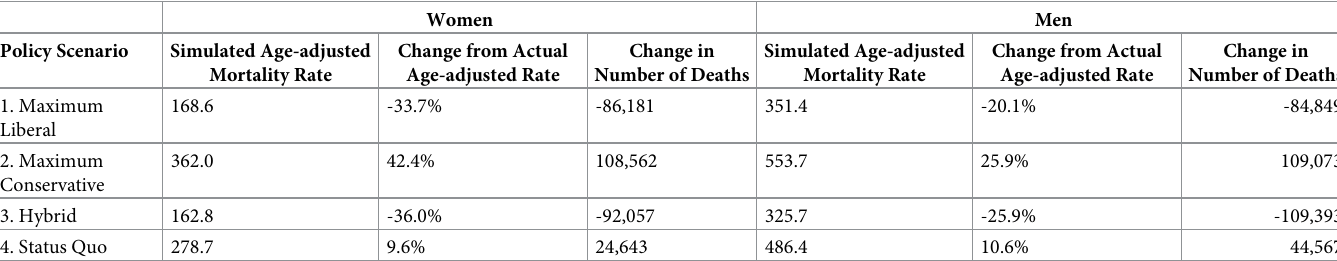
Table 3. Estimated change in the number of deaths in 2019 among adults ages 25–64 for hypothetical policy